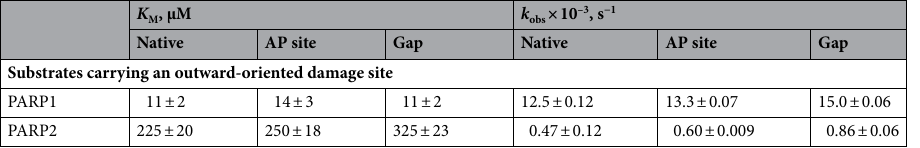
Table 2. K M and k obs values for PARylation by PARP1 or PARP2 during the interaction with a native NCP, AP-NCP or gap-NCP according to fluorescence anisotropy